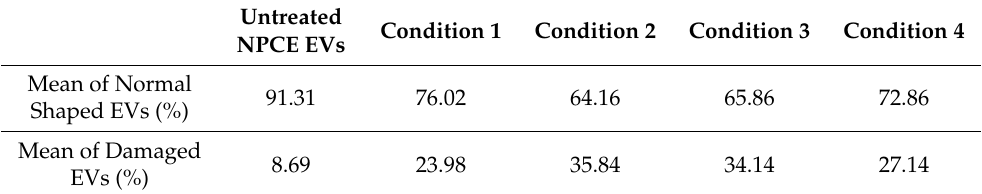
Table 2. Cryo-TEM analysis of NPCE-derived EVs before and after